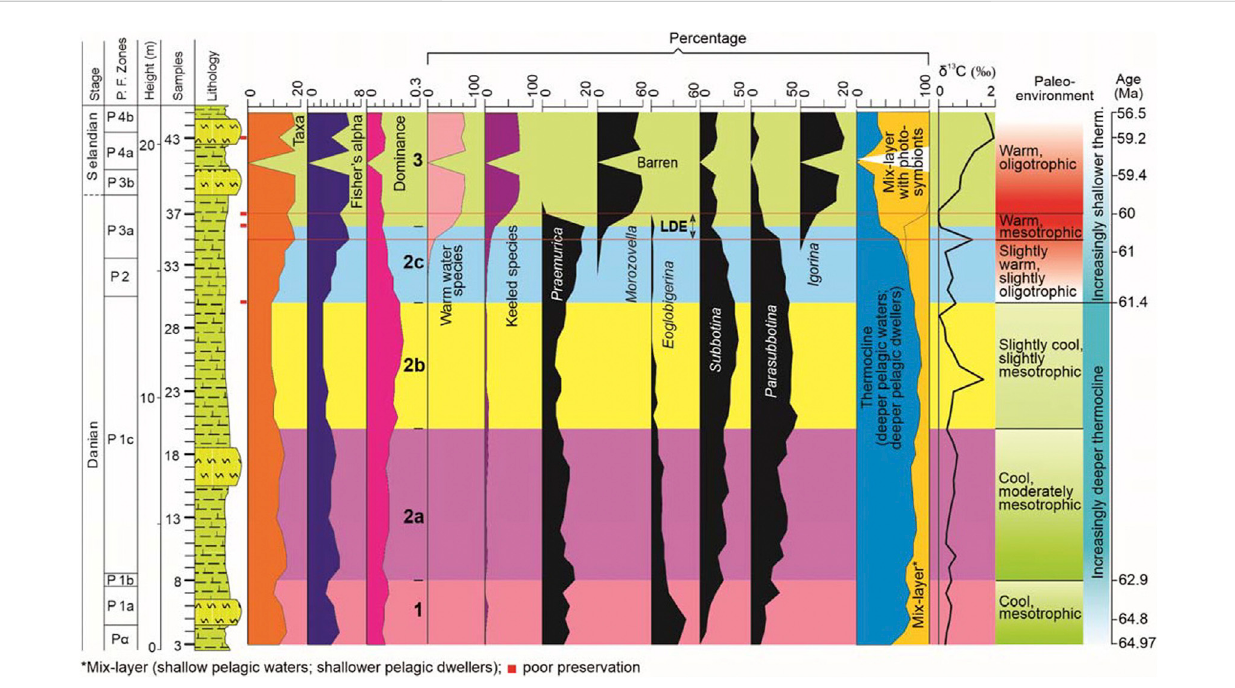
FIGURE 7 Proxiesusedto inferDanian ‒ Selandian paleoenvironment. The proxiesincludespecies diversity(numberoftaxa,Fisher ’ s α andspeciesdominance), relative abundances of warm water species, keeled species, Praemurica , Morozovella , Eoglobigerina , Subbotina , Parasubbotina , Igorina, and categorization of planktic foraminiferal species bae on their depth preferences (mix-layer with photosymbionts, mix-layer and thermocline dwellers), δ 13 C and inferred paleoenvironment based on these aforementioned proxies (see text for further